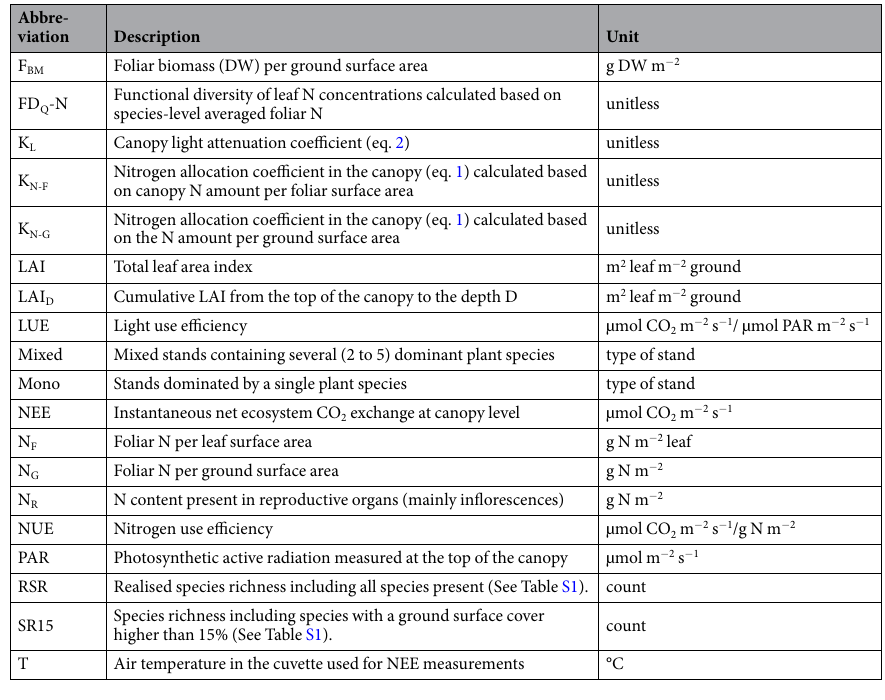
Effects of N allocation on the light and nitrogen use efficiencies of NEE. To explore the potential relationships between canopy N allocation and the nitrogen use efficiency (NUE) and light use efficiency (LUE) of instantaneous NEE while avoiding the intrinsic species-specific differences occurring in monocultures, we focused on mixed stand only. LUE was best predicted by a model that included a positive coefficient for K N-G as well as a negative temperature (T) effect (LUE = 0.018 − 0.0003 * T + 0.0015 * K N-G * N G ; P = 0.001, R 2 = 0.68). In contrast, the model for nitrogen use efficiency (NUE) was best predicted by K N-G , with a negative regression coefficient and the interaction between temperature and the percentage of legumes in the canopy, with a negative plot and correlation matrix depicting the relationships between NUE, LUE and their most important predictors. Discussion